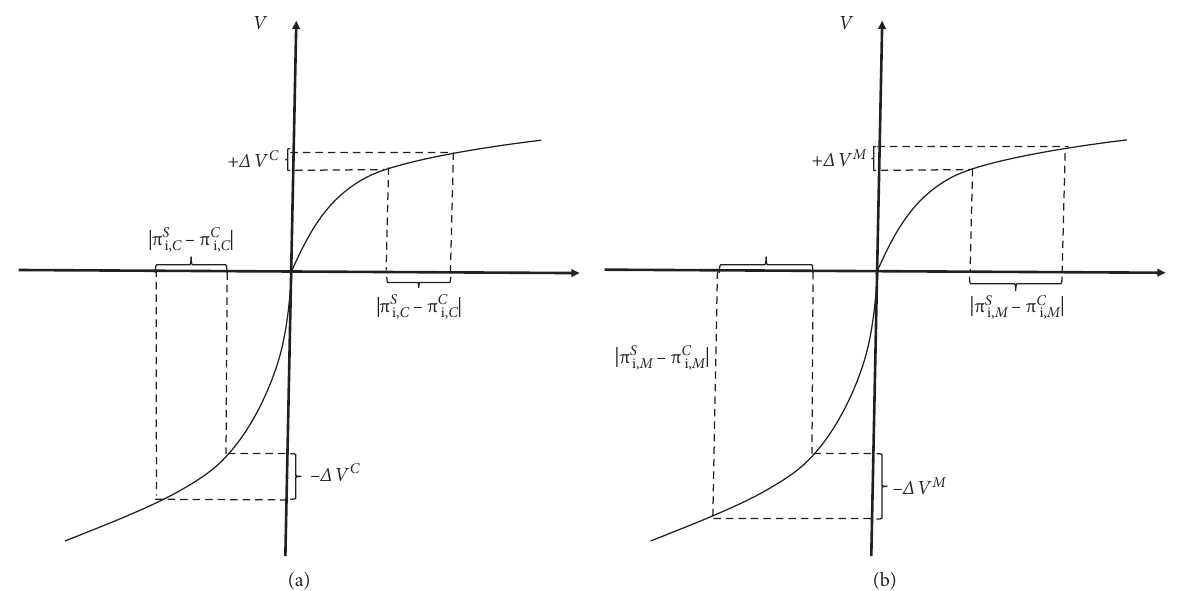
Figure 5: The difference of perception payoff between innovation (a) and imitation (b).